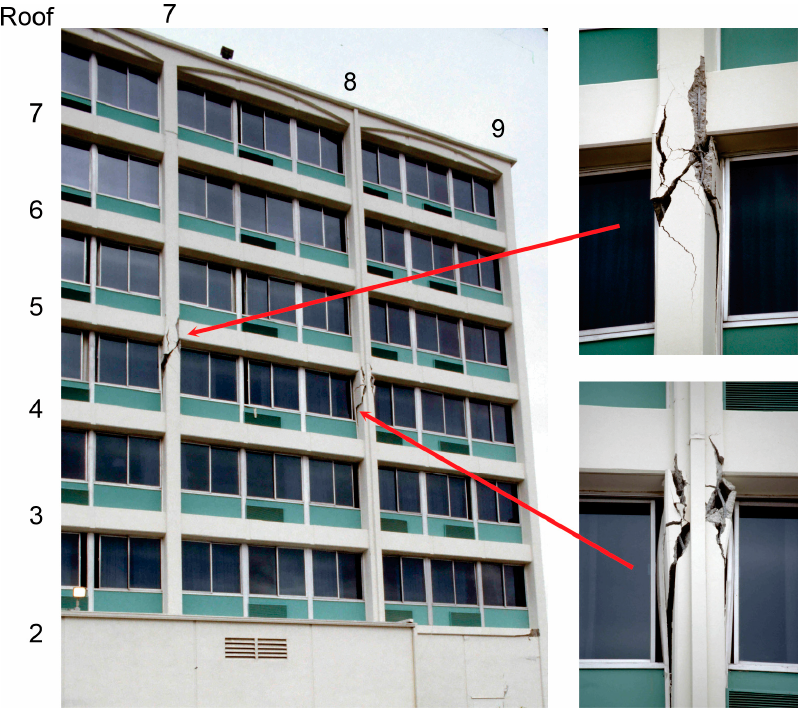
Figure 4. View of damaged columns A7 and A8 in frame A on the north side of the building after the Northridge earthquake (see Figure 2) [18].